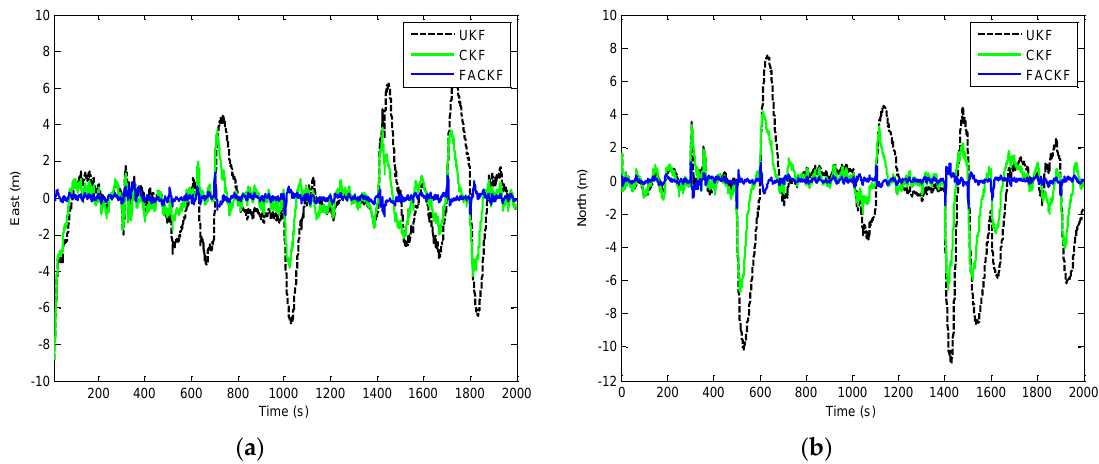
Figure 6. Position errors for EKF, UKF, and CKF—Scenario 1: ( a,c ) EKF versus UKF; and ( b,d ) UKF versus CKF.